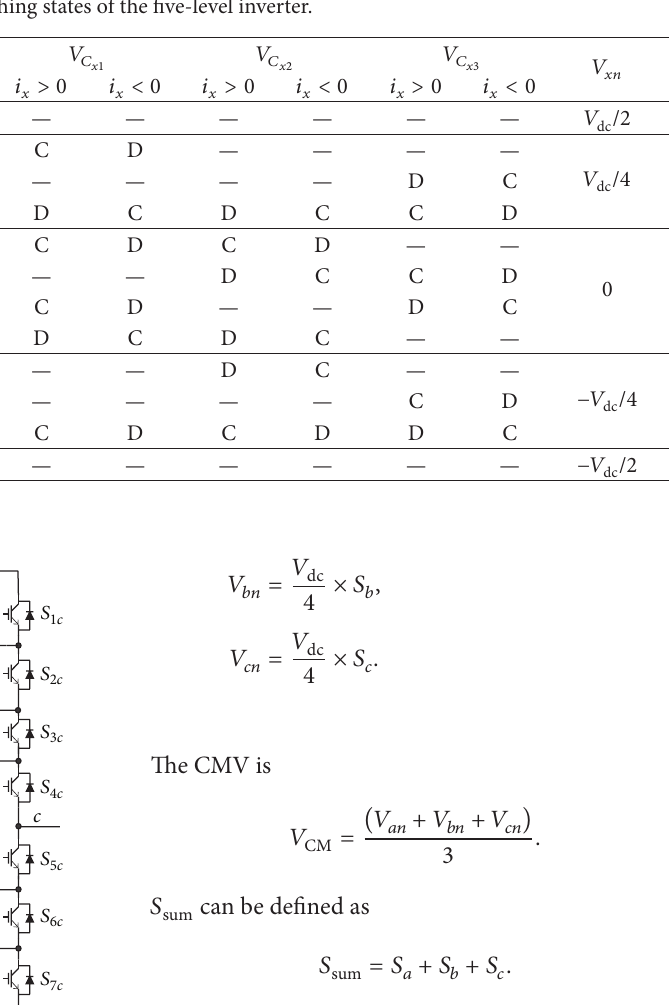
Table 1: Switching states of the five-level inverter.